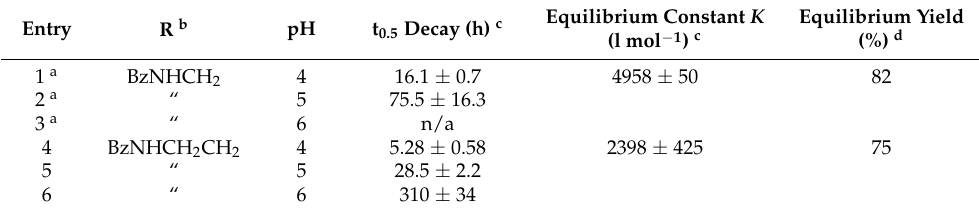
Table 2. Formation and decay of N -(methoxy)oxazolidines between 2 (cid:48) -deoxy-2 (cid:48) -( N -methoxyamino) uridine and small molecular